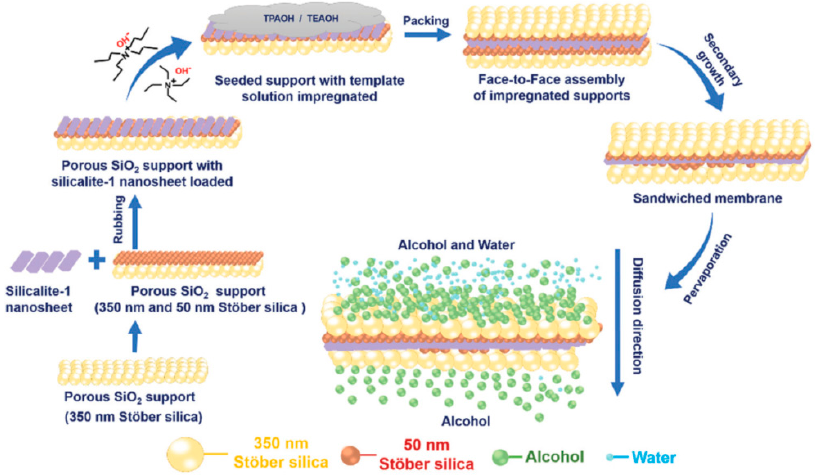
Figure 4. Graphical depiction of the sandwiched silicalite-1 membrane for the recovery of ethanol and n-butanol from water. Reproduced with permission from [59]; published by The Royal Society of Chemistry (RSC), 2020.